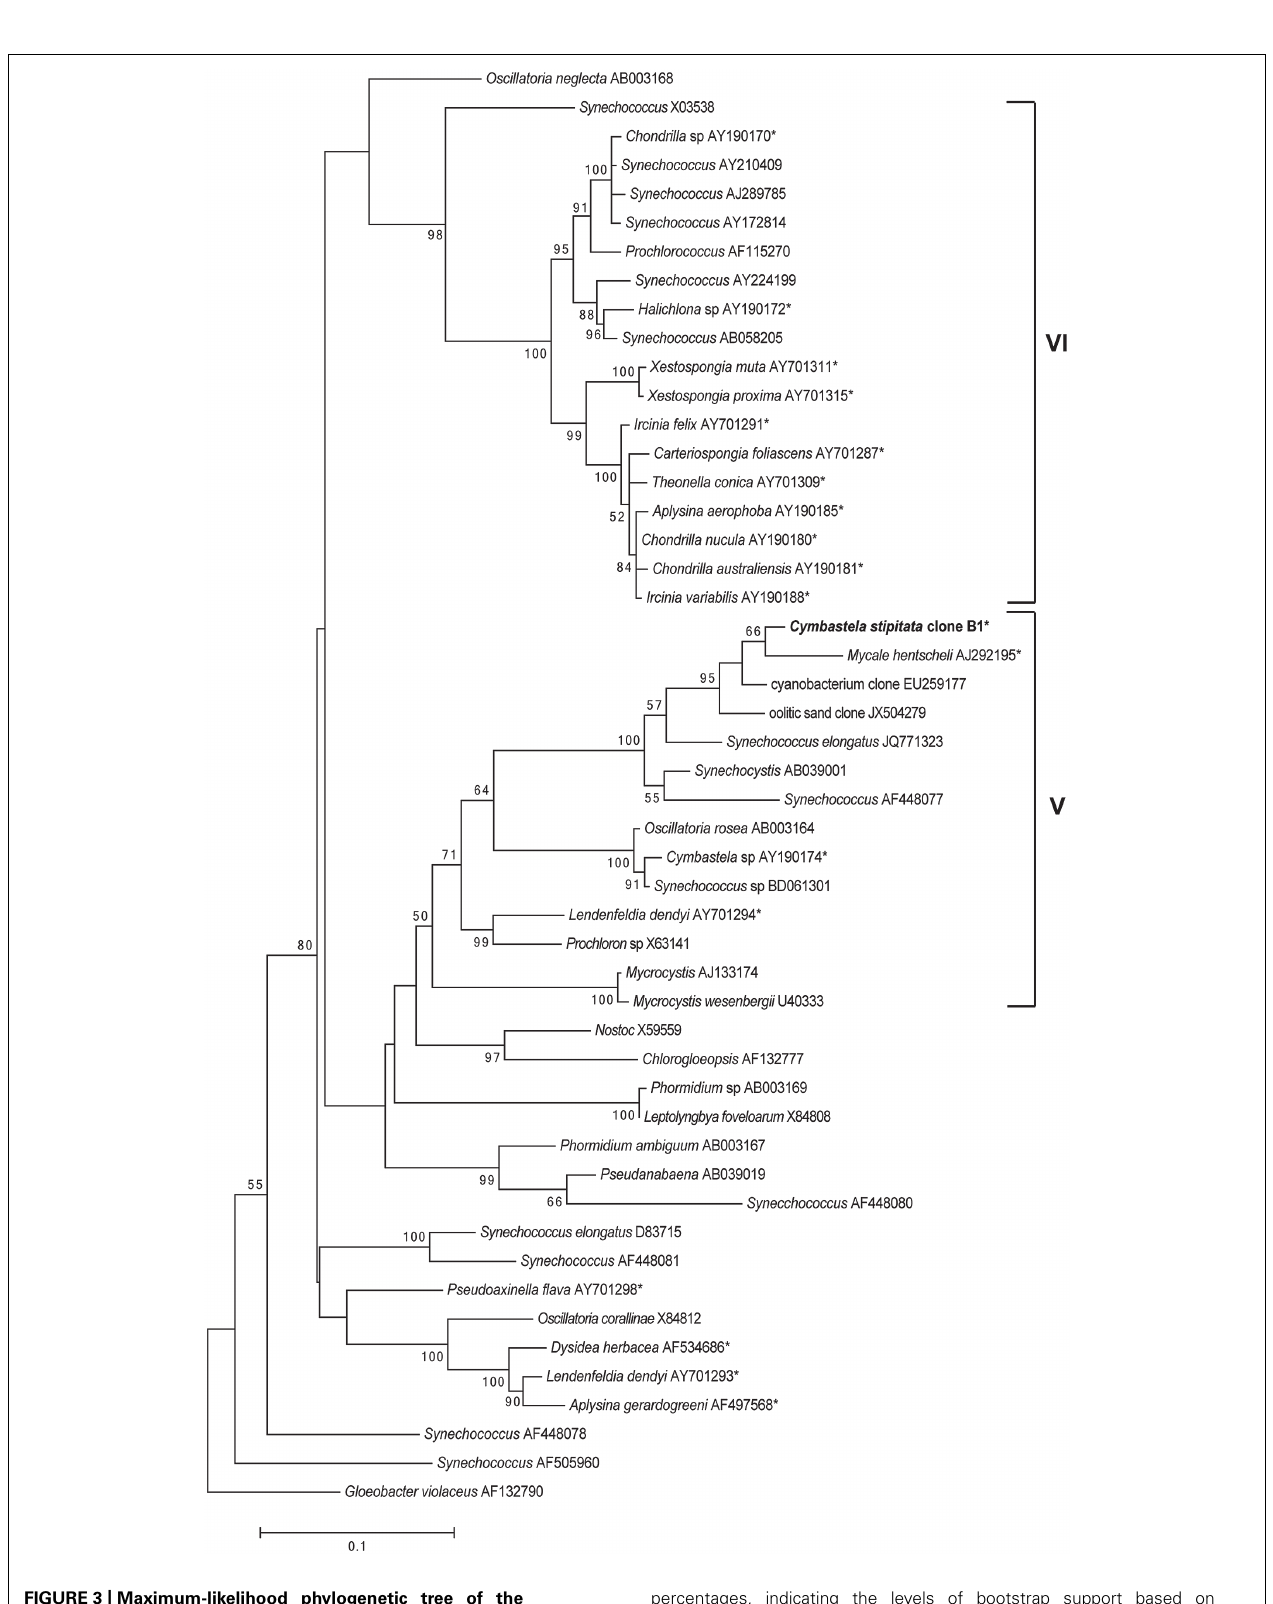
FIGURE 3 | Maximum-likelihood phylogenetic tree of the C. stipitata cyanobacterial clone, indicated by boldfacing, based on 16S rRNA sequences. Other sponge-associated Cyanobacteria are indicated by asterisks (*). The numbers at the nodes are